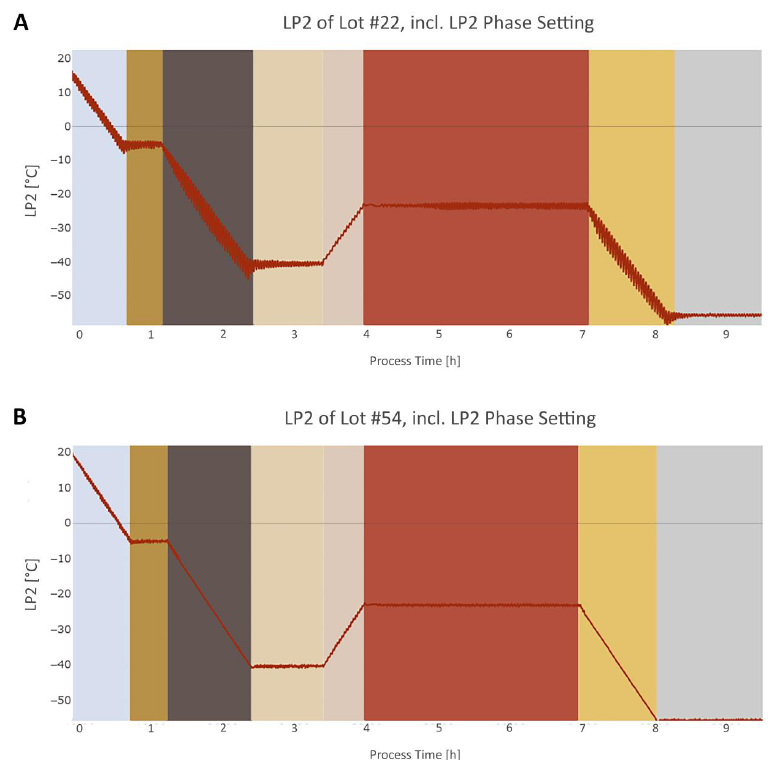
Figure 10. Segment of the LP2 signal (red line) over the process time of lot #22 ( A ) and lot #54 ( B ). The colored rectangles represent the individual phases for LP2, discussed in chapter 3.3.2. Step signal phase settings algorithms divide the signal into plateaus and slopes. The LP2 signal in ( A ) has a ~30% higher noise level than the LP2 signal in ( B ), which led to the high score distance in the robust PCA, as shown in Figure 8.